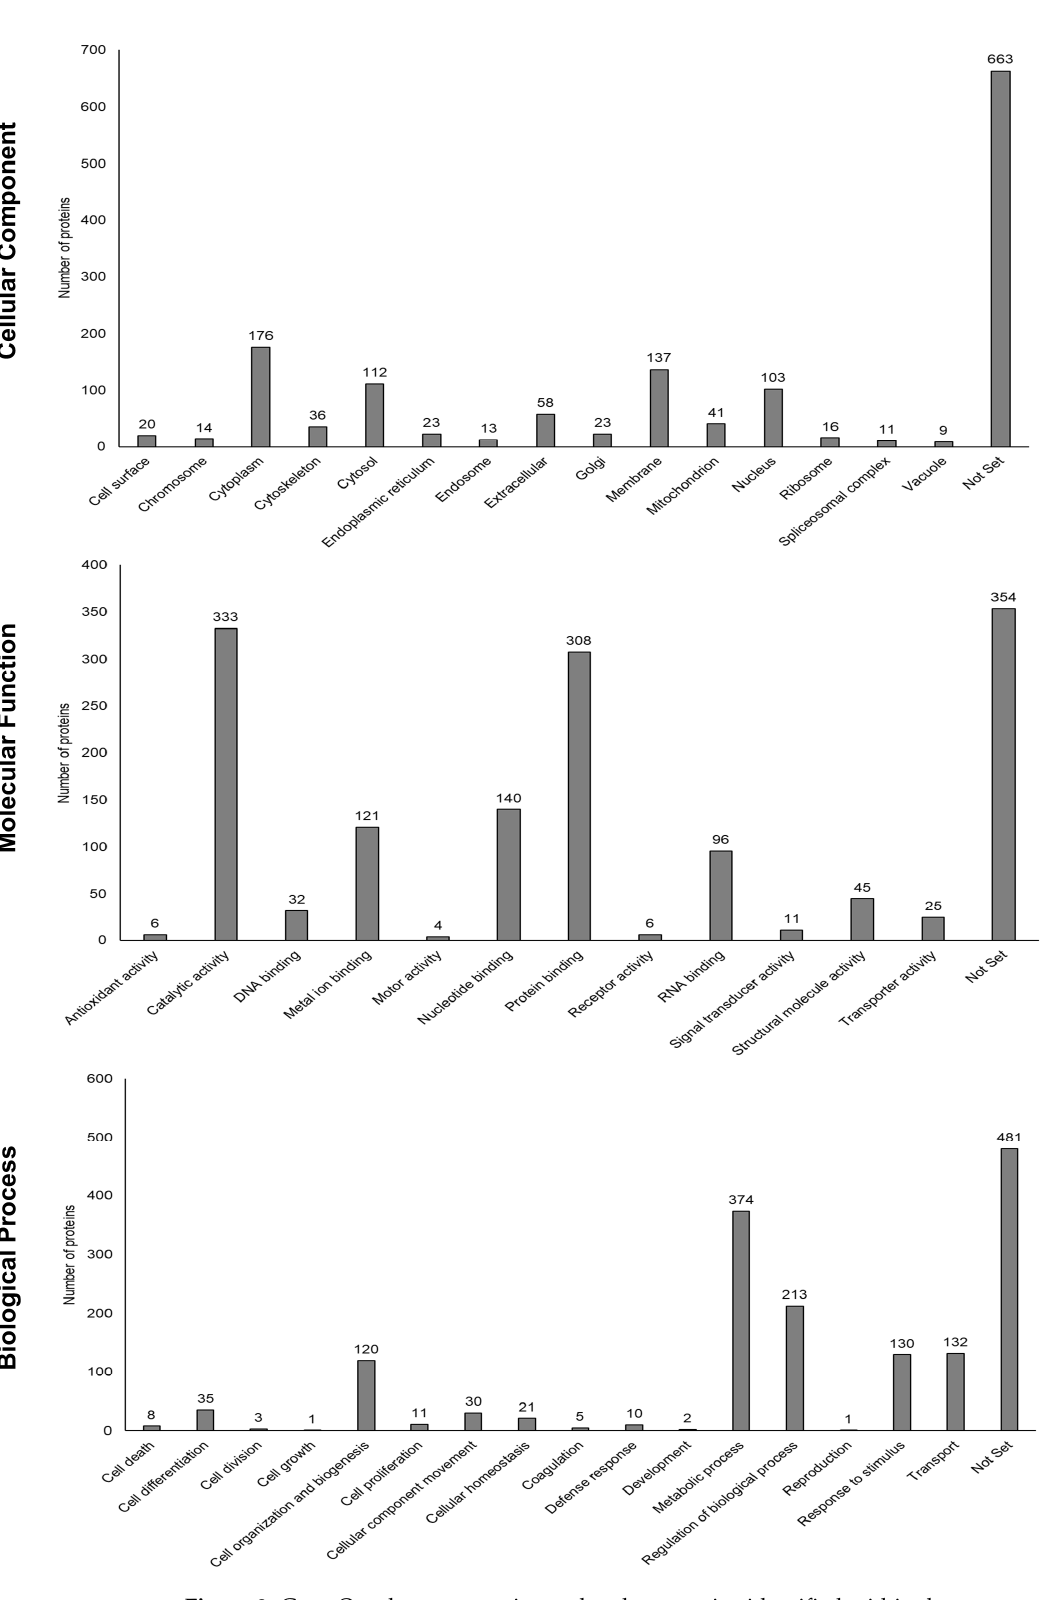
Figure 3. Gene Ontology annotations related to proteins identified within the secretomes produced by fAd-MSCs. A specific protein might be included in different subgroups. “Not set” denotes that these proteins could not be classified in any of the parameters described according to Gene Ontology (more information can be found in Table